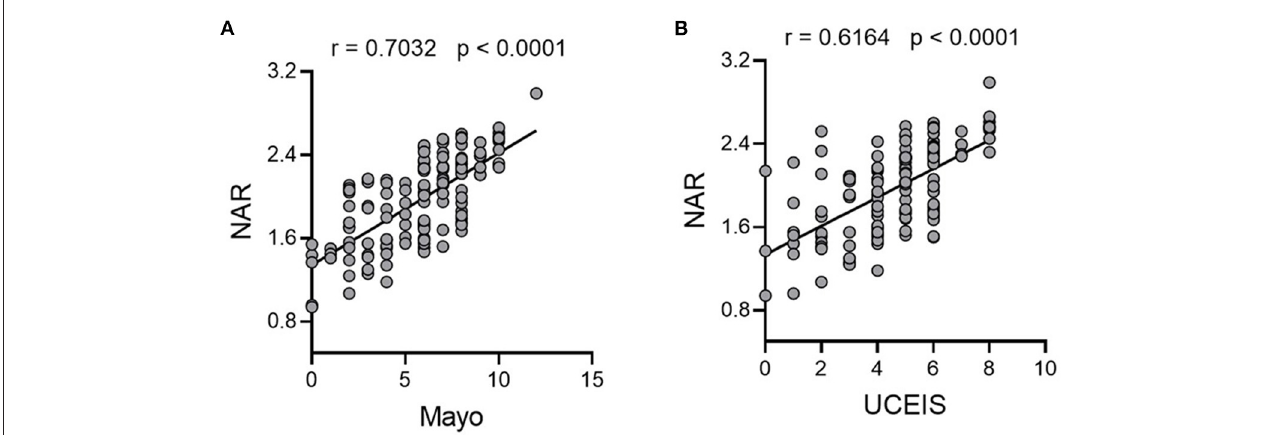
FIGURE 2 | NAR reflects disease activity in UC. All enrolled patients with UC ( n = 146) were subjected to disease activity evaluation by the Mayo score and the ulcerative colitis endoscopic index of severity (UCEIS) system. Associations between NAR and (A) Mayo score, and (B) UCEIS were examined. The correlation analysis was performed using Pearson’s correlation. p < 0.05 was considered significant.